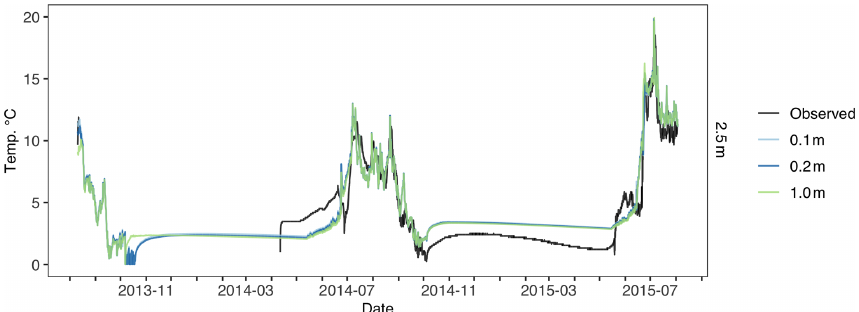
Figure E2. Atqasuk 2.5m water temperature across different soil vertical resolution simulations. Observed water temperature is in black, 0.1m vertical resolution is in light blue, 0.2m vertical resolution is in blue, and 1.0m vertical resolution is in green.